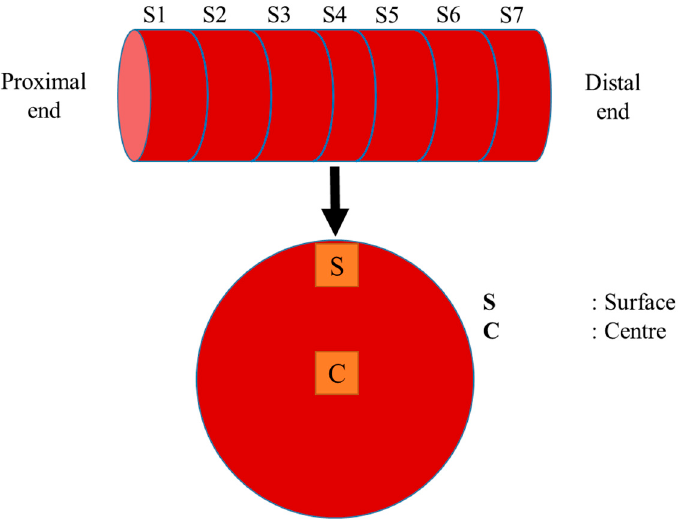
Figure 2. Schematic view of the slice allocation procedure set up for sampling both the tumbled and non ‐ tumbled (NT) ST muscles for microstructure (slice S4) and texture (slices 1–3 and 5–7) analyses.